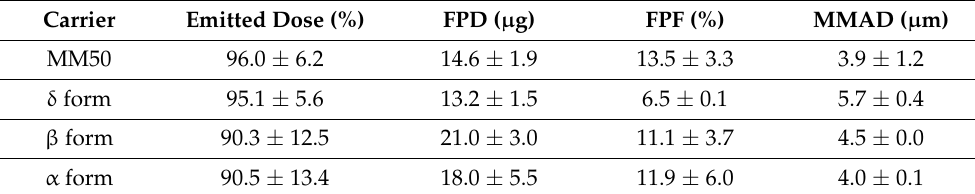
Table 4. Deposition profiles of salbutamol sulphate from MM50, α , β and δ in an ACI after